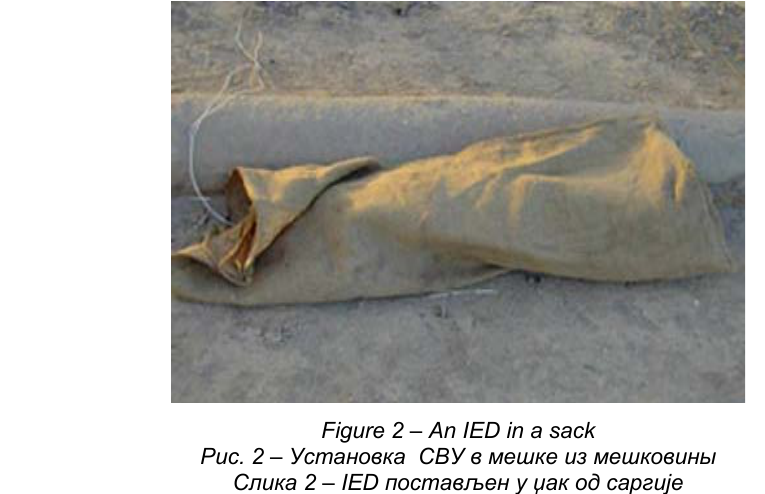
Рис . 2 – Установк a СВУ в мешке из